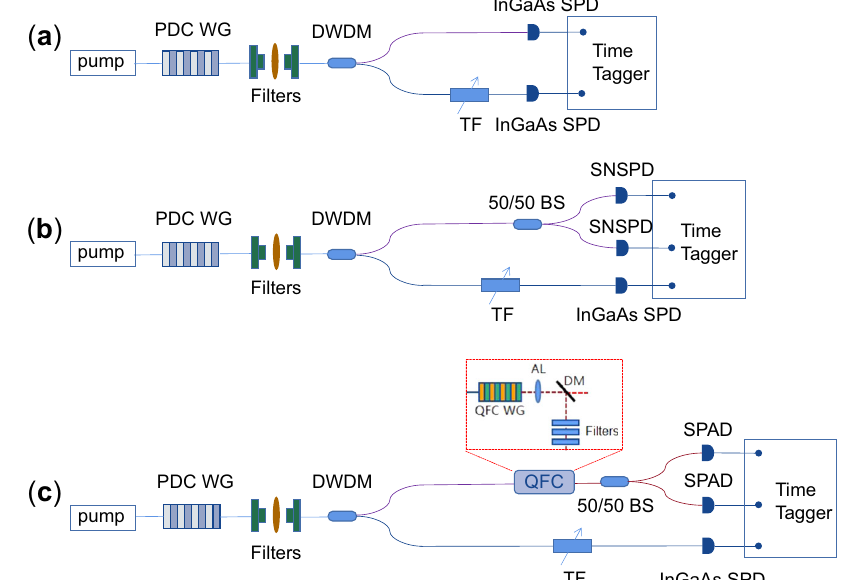
Fig. 4 The second-order correlation function measurement setups. a Photon pair, b heralded single-photon source, and c QFC of the herald single photon. DWDM dense wavelength division multiplexer, BS beam splitter, SPD single-photon detector, TF tunable fi lter, PDC WG parametric down conversion waveguide, SNSPD superconducting nanowire single photon detector.